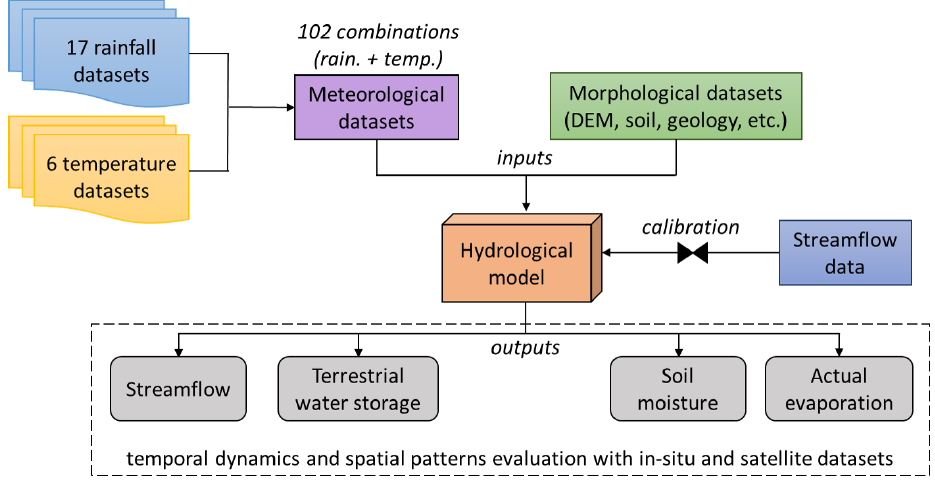
Figure 1. Flowchart of the methodology used to evaluate the suitability of meteorological datasets in reproducing plausible hydrological